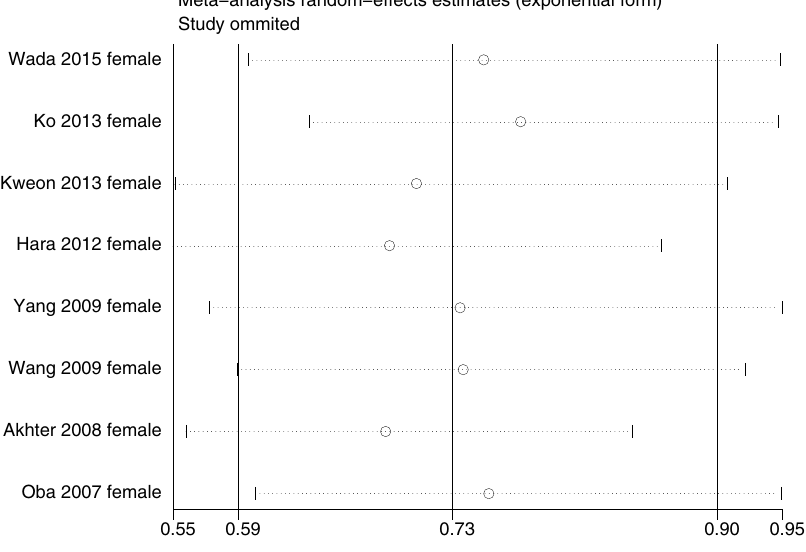
Figure 5. Sensitivity analysis for females of soy product intake and incidence of GI